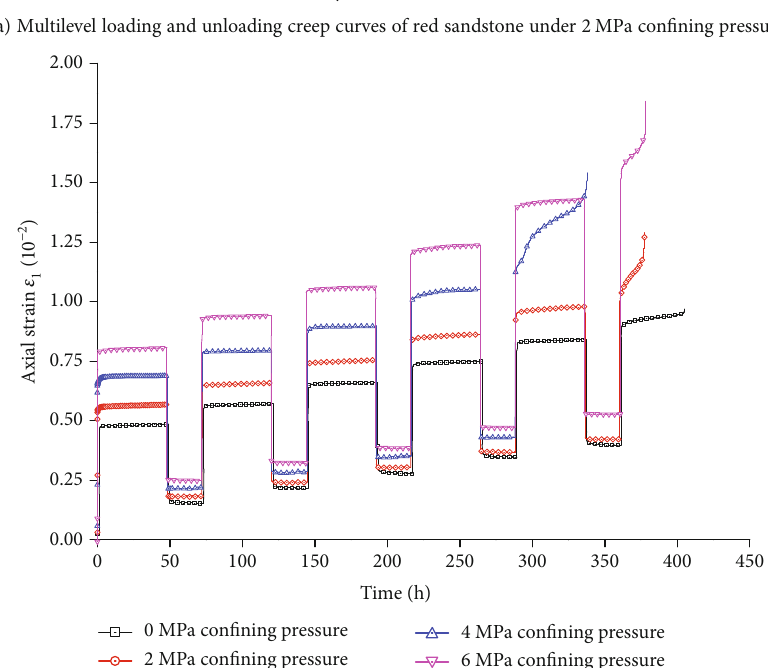
Figure 10: Multilevel loading and unloading creep curves of the tested red sandstone after di ff erent (a) numbers of freeze-thaw cycles and (b) con fi ning